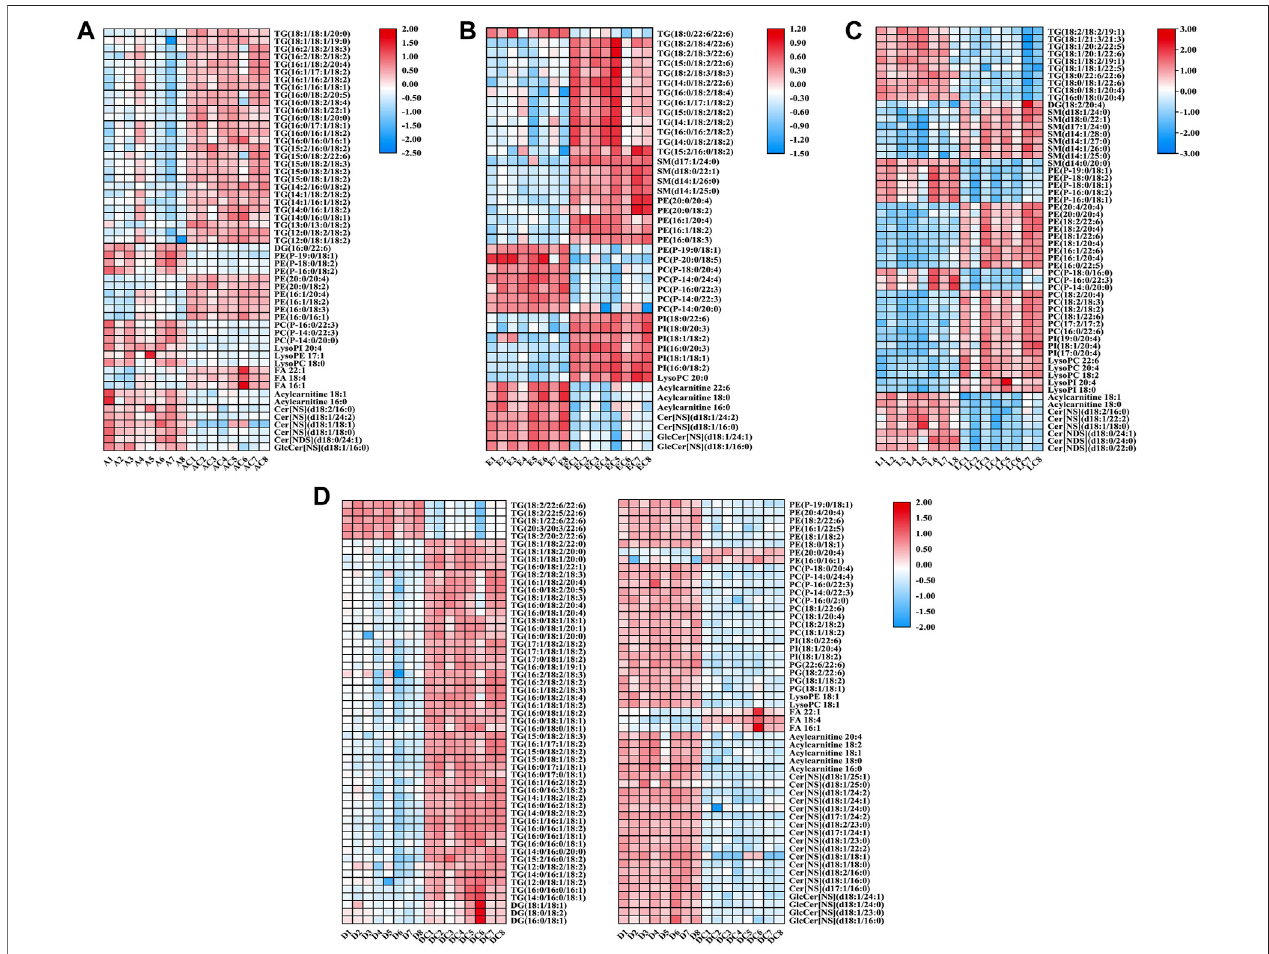
FIGURE 6 | Heatmaps of altered lipid species between acute intrahepatic cholestasis models and NCs. Colors indicated expression quantity, with blue and red representinglowerandhigherexpression,respectively. (A) ANITgroupvs.ANIT-Cgroup. (B) EEgroupvs.EE-Cgroup. (C) LCAgroupvs.LCA-Cgroup. (D) DDCgroup vs. DDC-C